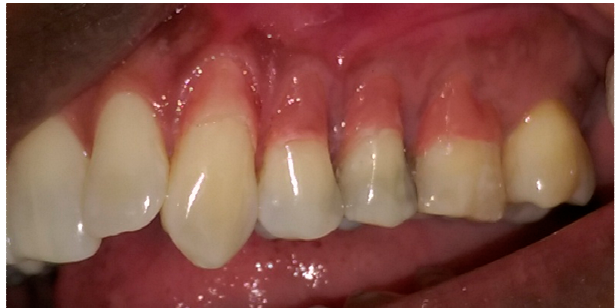
Figure 6. Placement and sculpting of nature shade composite.